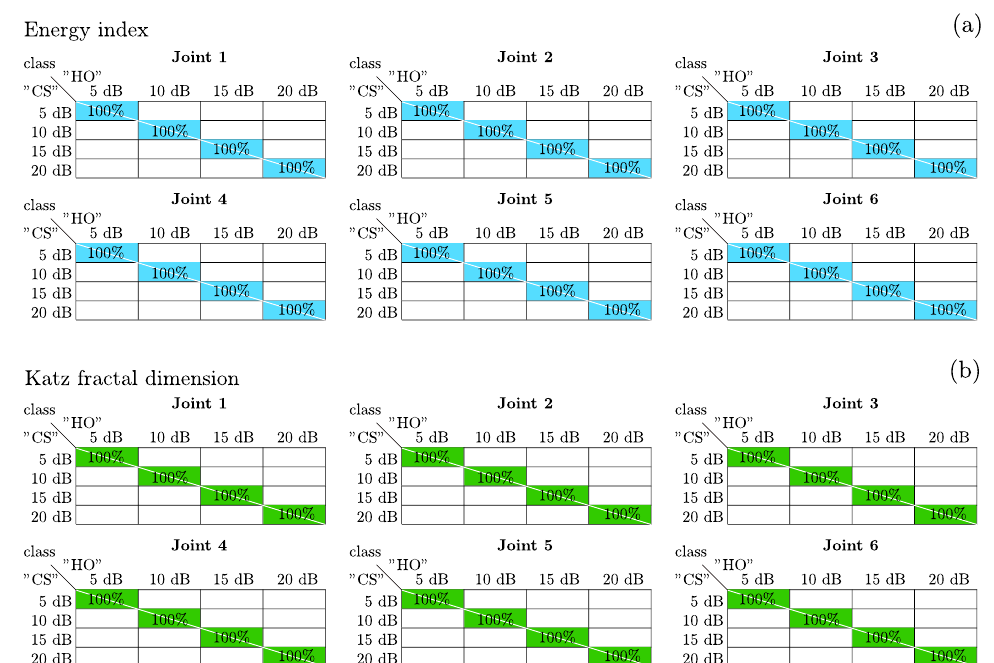
Figure 12. Confusion matrix accuracy of half- and full-speed cases using mixed noise level samples for validation: ( a – c ) results corresponding to joints 1 to 3; ( d – f ) results corresponding to joints 4 to 6.